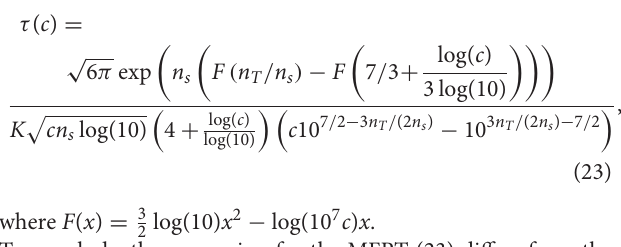
To conclude, the expression for the MFPT (23) differs from the one computed in Lagache et al. [11] (Equation 5) derived for a linear unbinding rate l ( x , c ) k 1 xn s . Equation (23) links the = − affinities between the ligand (concentration c ) and the binding sites of a trimer to the conformational change mean time τ ( c ) of the trimer. The two unknown parameters of the conformational MFPT (Equation 23) are the binding rate K of protons to HA sites and the number n T of sites that have to be protonated (among the n s 9 total sites) to trigger the HA change of =